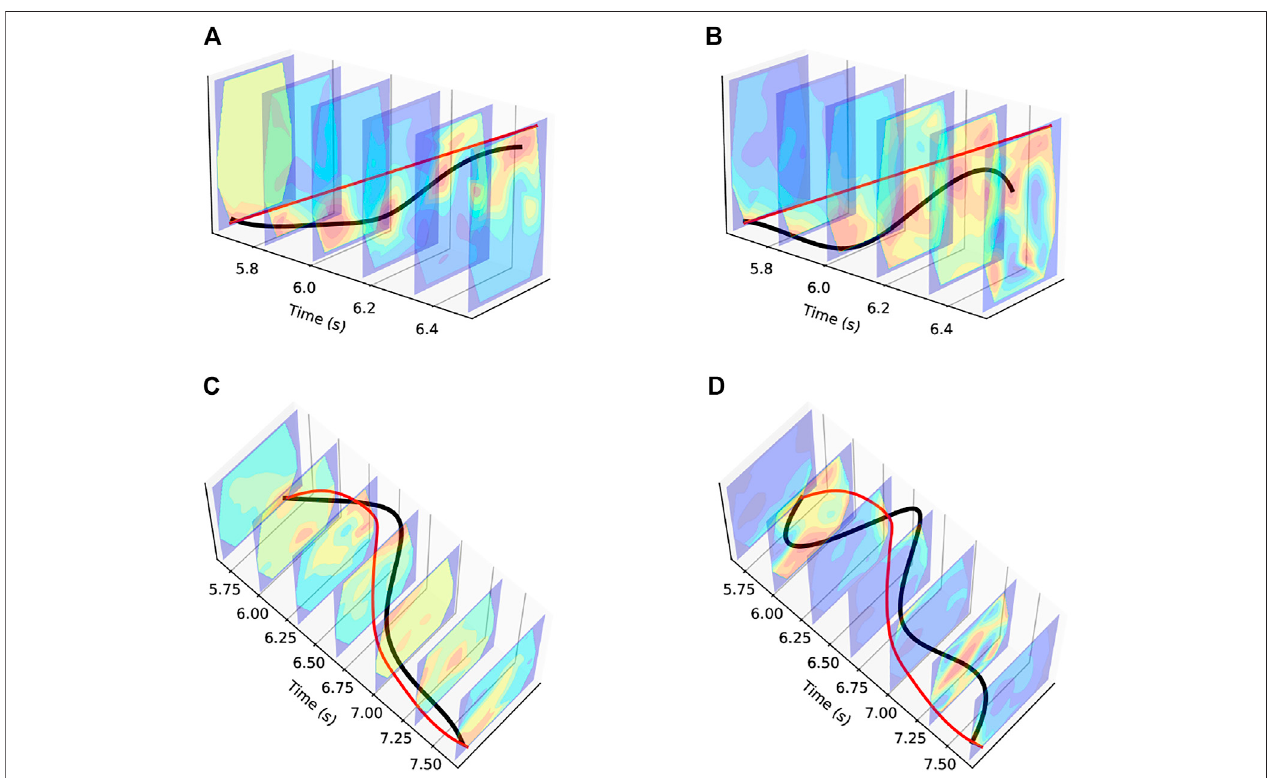
FIGURE 6 | Touch Tracking Trajectory Plots. The red line denotes the ground truth trajectory. (A) Diagonal Trajectory using Events Data, (B) Diagonal Trajectory using Raw Data, (C) Circular Trajectory using Events Data, (D) Circular Trajectory using Raw Data.